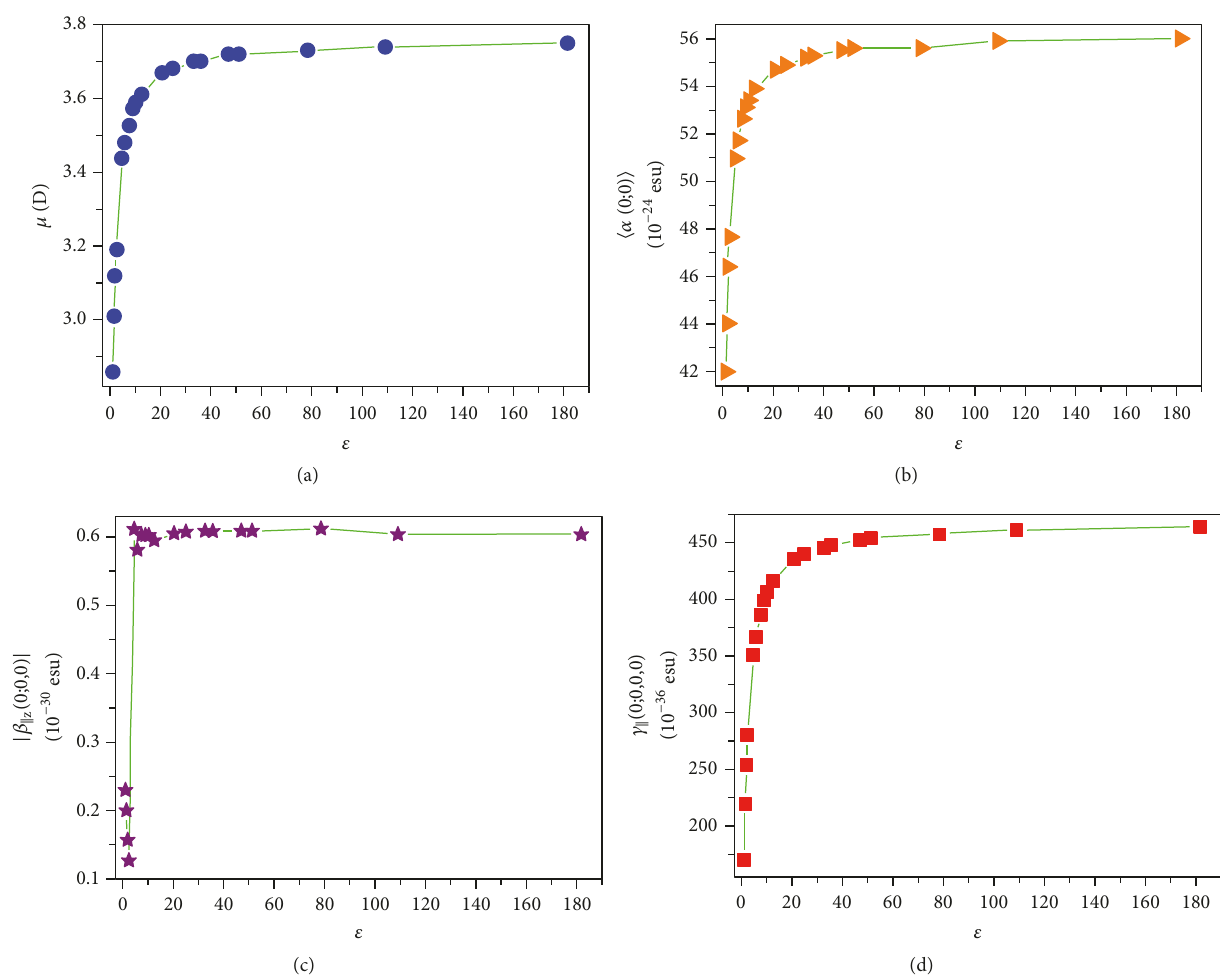
Figure 5: DFT static results for the EPAF electric parameter as function of the 𝜀